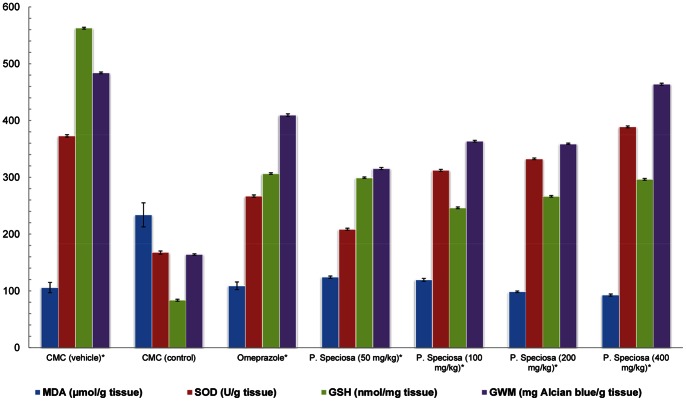
The effects of P. speciosa on SOD, MDA, GSH and GWM in the gastric mucosa homogenate of ethanol-induced gastric mucosal lesions in rats.All values are expressed as the mean ± standard error of the mean. All P. speciosa-treated groups were significantly different from the control groups at p0.05. The data were analyzed by one-way ANOVA using the Statistical Package for the Social Sciences software (SPSS 18).